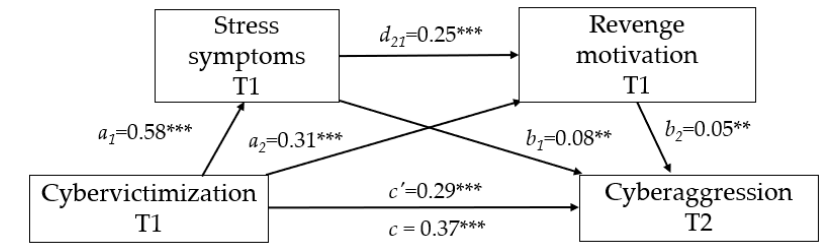
Figure 2. Results of serial multiple mediating test (Model 6) for stress and revenge as mediators.